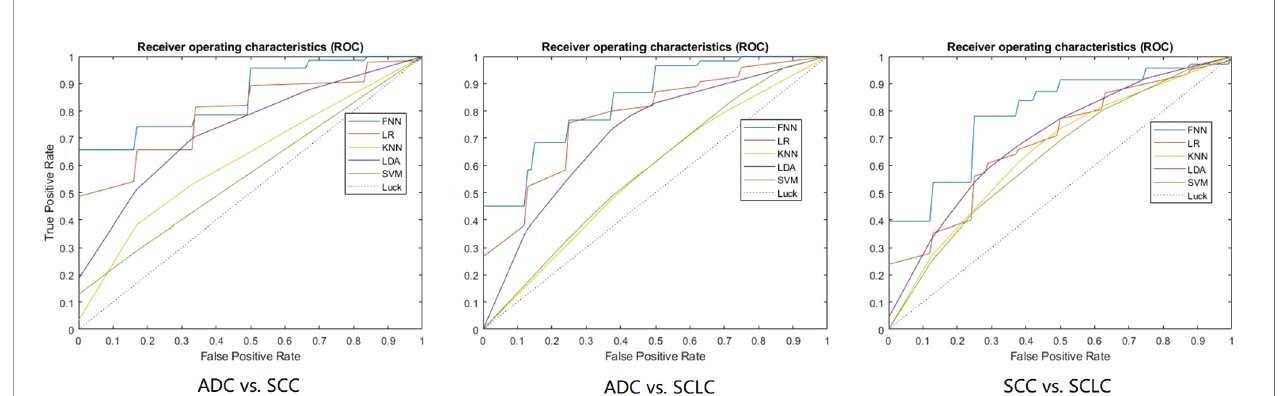
FIGURE 2 | The ROC curves of the optimal model for each classi fi cation task. 10-fold cross-validation and fi ve machine learning classi fi ers were utilized for predictive model construction in three tasks. In each ROC, the blue curve is the ROC of the model using the FNN classi fi er, the brown curve is the ROC of the model using the LR classi fi er, the yellow curve is the ROC of the model using the KNN classi fi er, the purple curve is the ROC of the model using the LDA classi fi er, and the green curve is the ROC of the model using the SVM classi fi er.